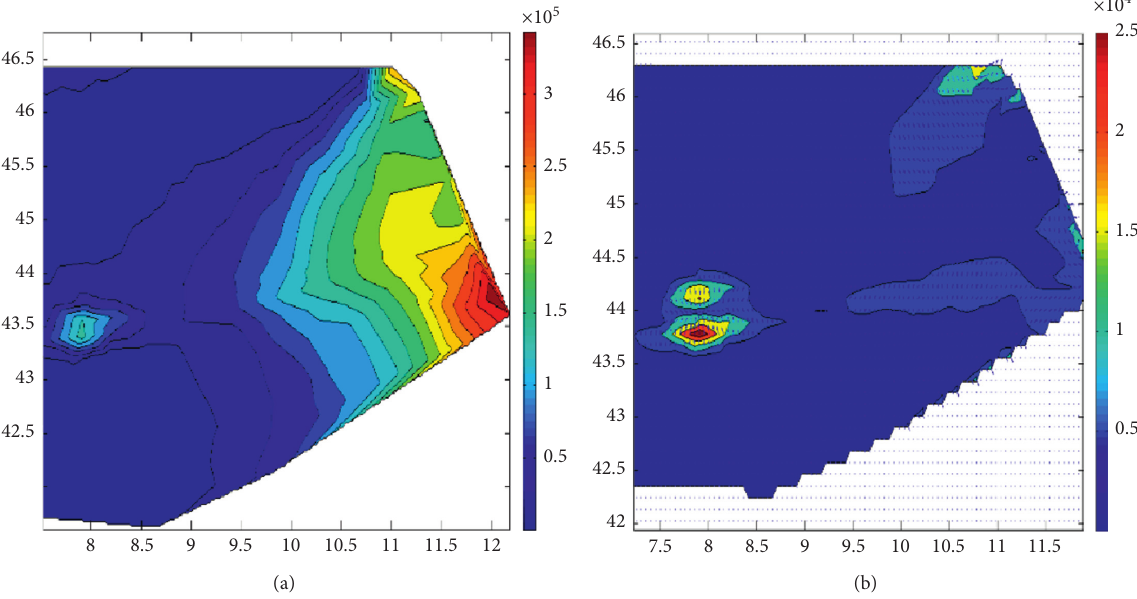
Figure 5: SED contour map and SEDG two-dimensional vector diagram of a shoulder. (a) SED contour map. (b) SEDG 2D vector